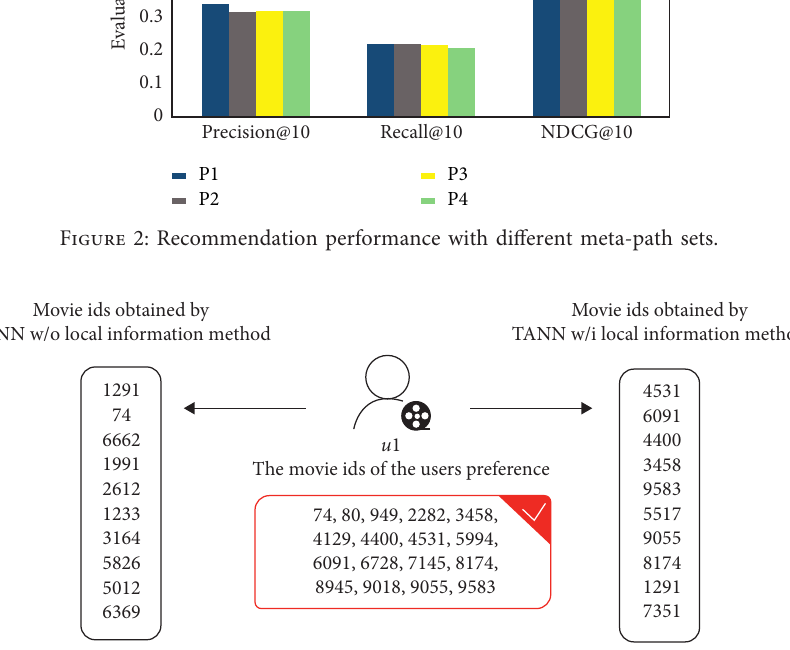
Figure 3: An example of removing local information in the TANN method.